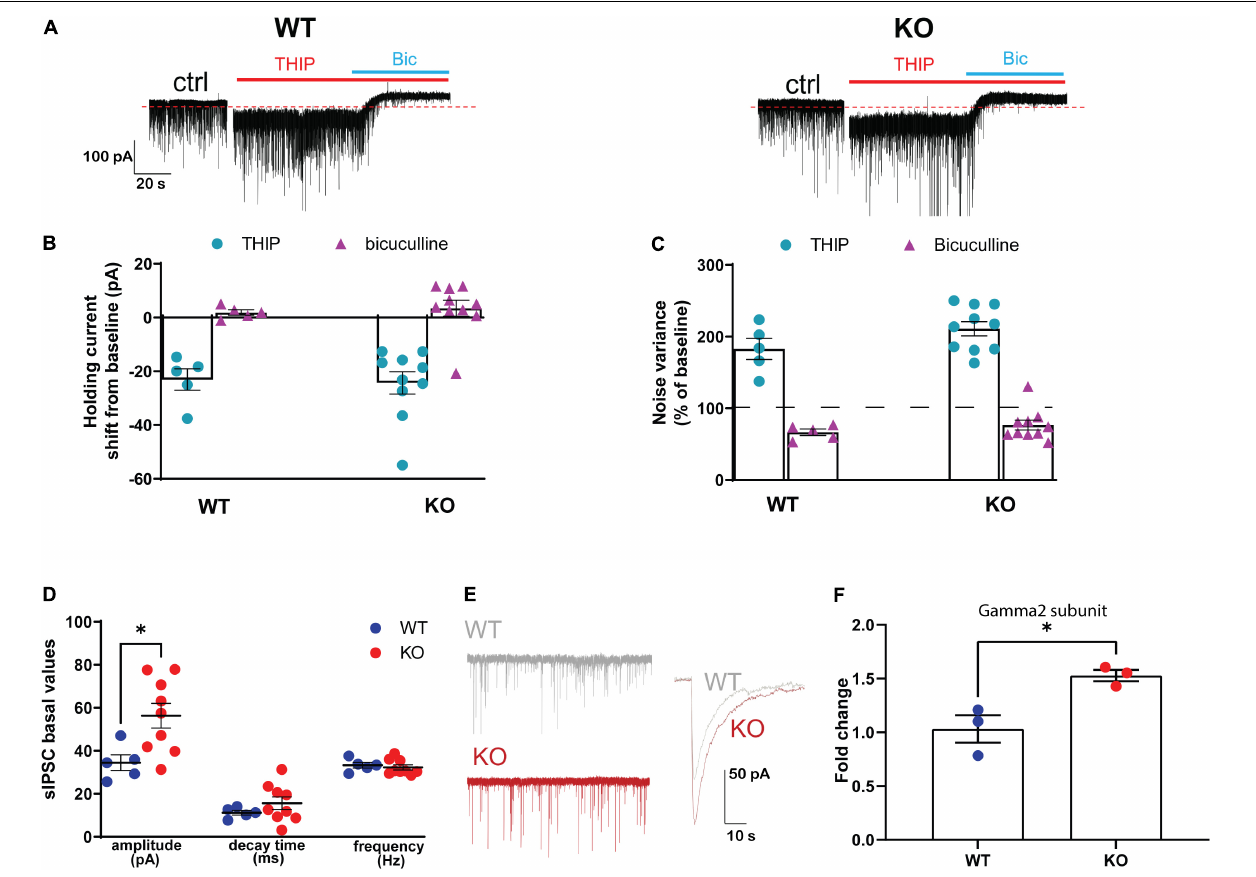
FIGURE 4 | Effect of genetic ablation of GABA B ( 1 ) on GABAergic tonic and phasic currents in granule cells of the dentate gyrus. (A) Representative traces of whole-cell mode recording of GABAergic tonic currents from GABA B ( 1 ) WT (left) and KO (right) mice. After 3 min of baseline, the application of 3 µ M THIP increased tonic currents that were blocked by the application of 20 µ M bicuculline (Bic). Calibration, 100 pA, 20 s. Panel (B) shows the negative shift in the holding current following THIP application (WT, n = 5; KO, n = 10) and panel (C) shows the increase in noise variance compared to the baseline following THIP application (WT, n = 5; KO, n = 10). All GABAergic currents in panels (B,C) were blocked by bicuculline. (D) Bar graphs represent the analysis of GABAergic spontaneous IPSCs (sIPSCs), summarizing the changes in sIPSC amplitude expressed in picoampere (pA); decay time is expressed in milliseconds (ms), frequency in hertz (Hz) (WT, n = 5; KO, n = 9). Post hoc test ( ∗ p < 0.05). (E) Representative trace of sIPSC amplitude highlighting the difference between GABA B ( 1 ) WT and KO mice. Calibration 50 pA, 10 s. (F) mRNA level of the Gamma2 subunit in the hippocampus of alcohol-naïve GABA B ( 1 ) WT and KO mice. Unpaired t -test ( ∗ p < 0.05) ( n = 3/group). All data are expressed as mean ±